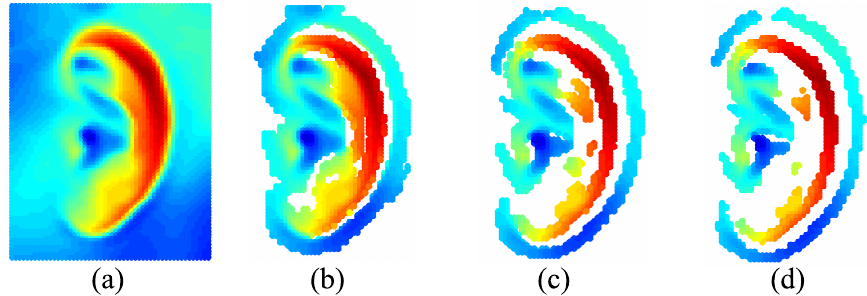
Figure 4. The results of processing with different thresholds: ( a ) The original ear data; ( b ) The results of σ t = 0.01; ( c ) The results of σ t = 0.02; ( d ) The results of σ t =